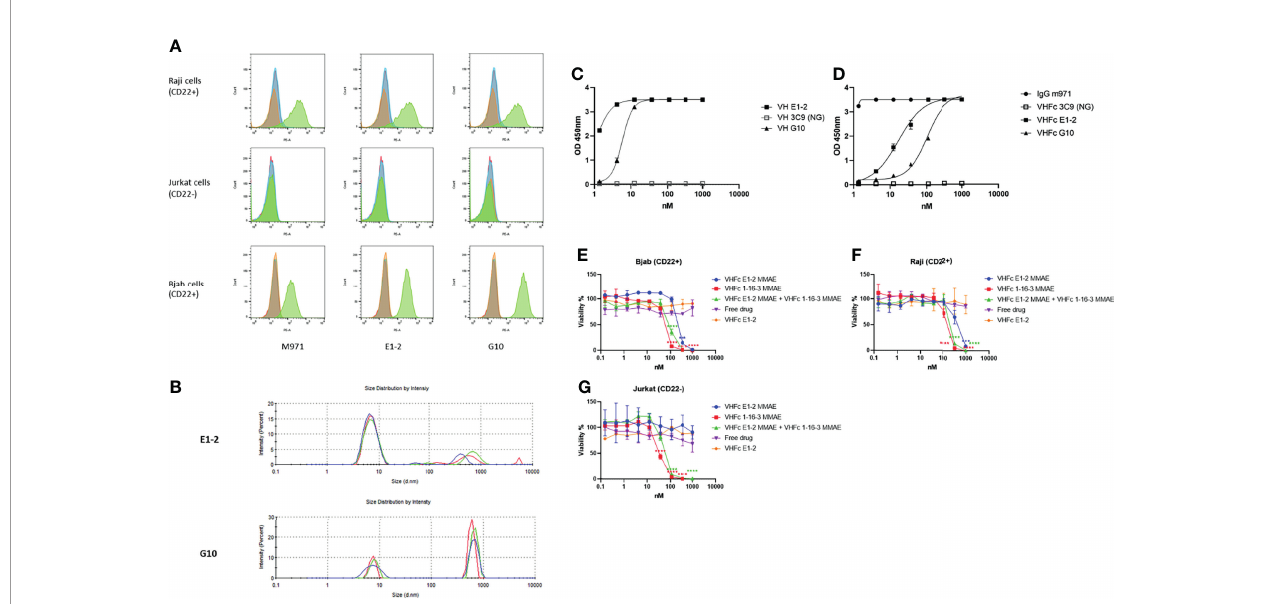
FIGURE 4 | Characterization of VH domains E1-2 and DDC design an example of the potential application. (A) Flow cytometry analysis for binding of domains to CD22 expressed on the surface of Raji cells and Bjab cells (Jurkat cells as negative control); yellow peaks represent unstained cells, blue peaks represent cells stained with PE conjugated secondary antibody only, red peaks represent cells stained with isotype control and then PE conjugated secondary antibody, green peaks represent cells stained with VH domains or m971 (positive control), and then PE conjugated secondary antibody; (B) Dynamic light scattering analysis for evaluation of the aggregation propensity of domains E1-2 and G10 after 24 hours incubation at 37°C; (C, D) ELISA of E1-2 and G10 against CD22 with or without human IgG1 Fc; (E – G) 1-16-3 and E1-2 based antibody domain drug conjugates in killing CD22 positive leukemia cells. Signi fi cance was tested using one-way ANOVA, followed by the tukey ’ s multiple post hoc test.